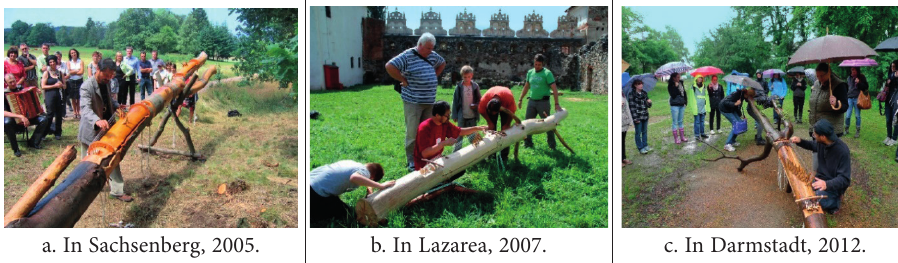
Table 3. Seung-Hyun Ko at work on his gayageum project (source: Courtesy of Yatoo )